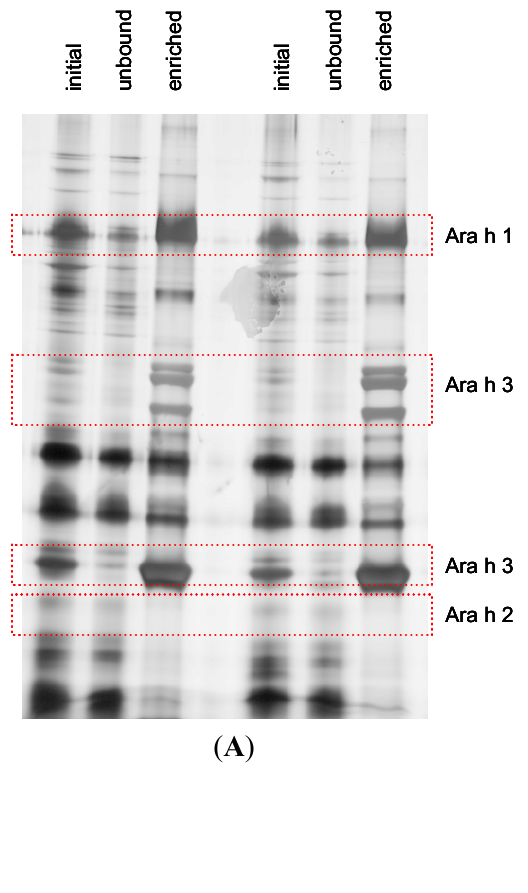
Figure 3. Enrichment of major peanut allergens through peptide ligand libraries (ProteoMiner™). ( A ) IRMM-481f peanut mix sample; ( B ) 16 min baked cookies incurred with 1000 μ g IRMM-481f peanut mix g − 1 matrix. Different amounts of starting material were extracted. Protein loaded was normalized to 5 μ g per lane to allow